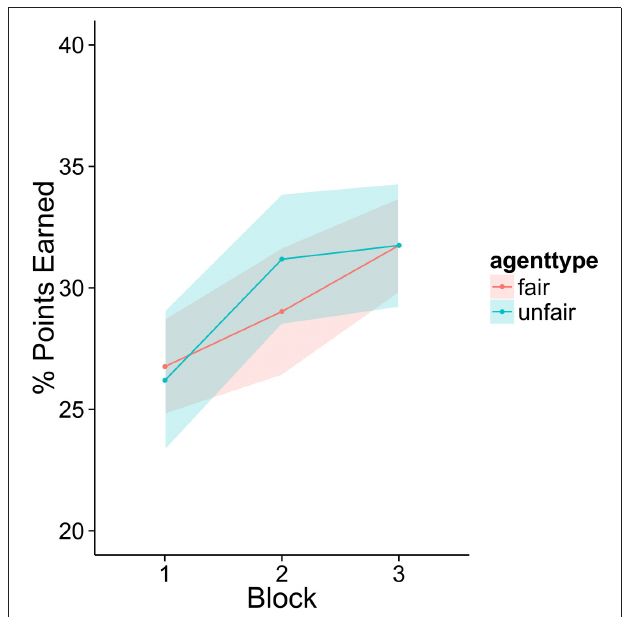
FIGURE 2 | The percentage of total points available in each block earned by the participants. There was very little change across the three blocks of the experiment. Fifty percent represents the ideal outcome: the agent and player each take half of the possible points. None are wasted due to failures to reach agreement.